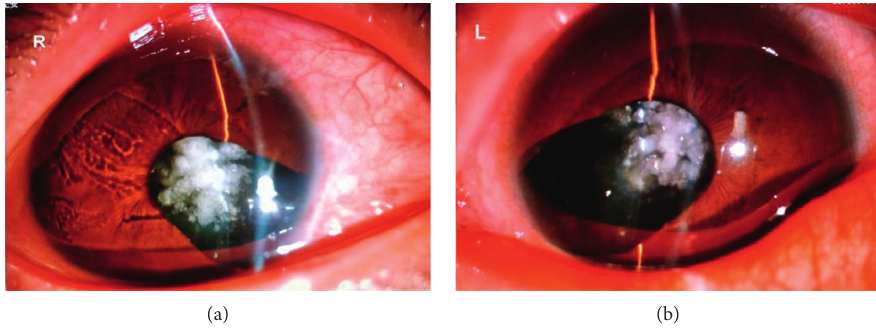
Figure 2: Proband (II:1). Photograph of the anterior segment of the slit lamp. It can be seen that the bilateral cornea of the patient is clear, the pupil is not round, the iris is missing, and the central cauliflower pattern is